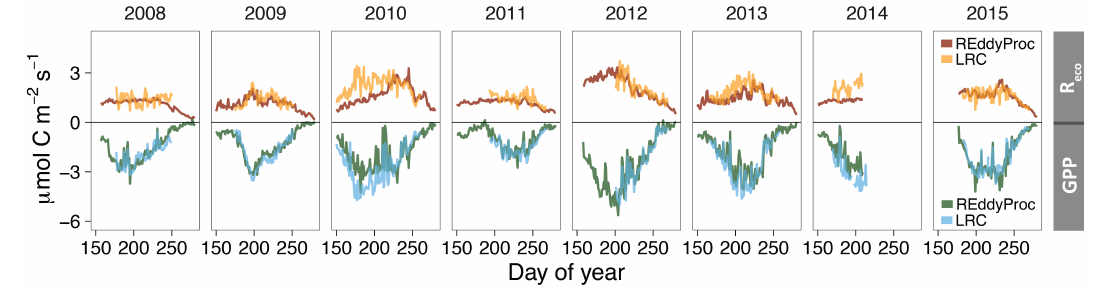
Figure 4. Time series of daily mean GPP (negative fluxes) and R eco (positive fluxes) from 2008 to 2015 calculated by REddyProc (dark green and dark red) and LRC (orange and light blue).